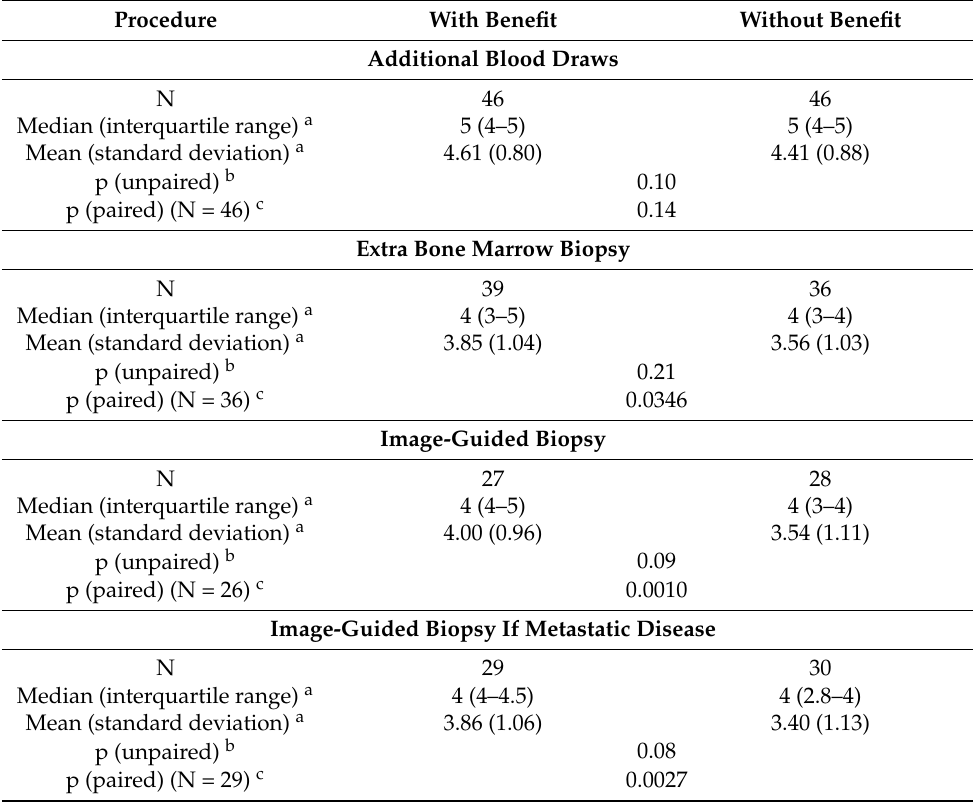
Table 3. Comparisons of survey responses based on benefit to their